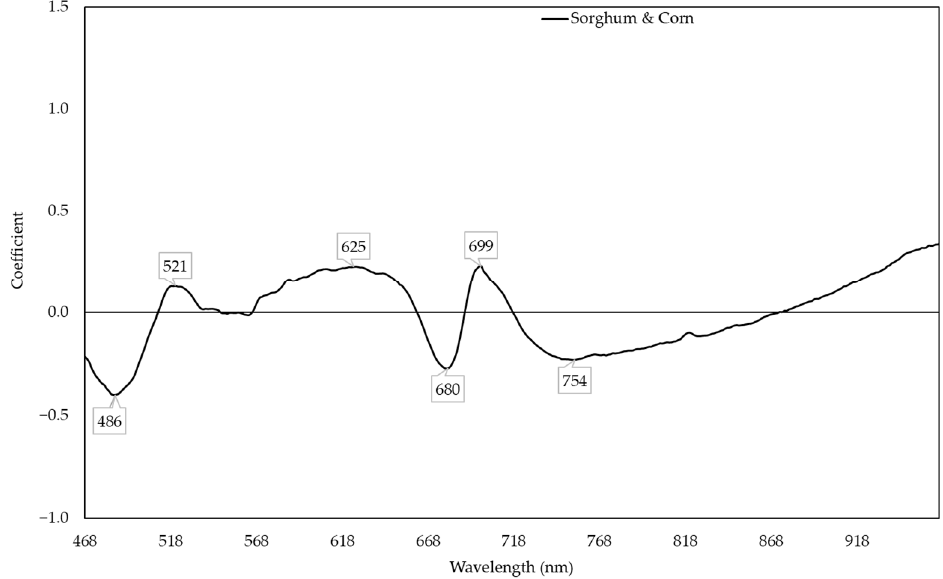
Figure 7. Coefficient in models predicting nitrogen content with the responses of sorghum and corn.